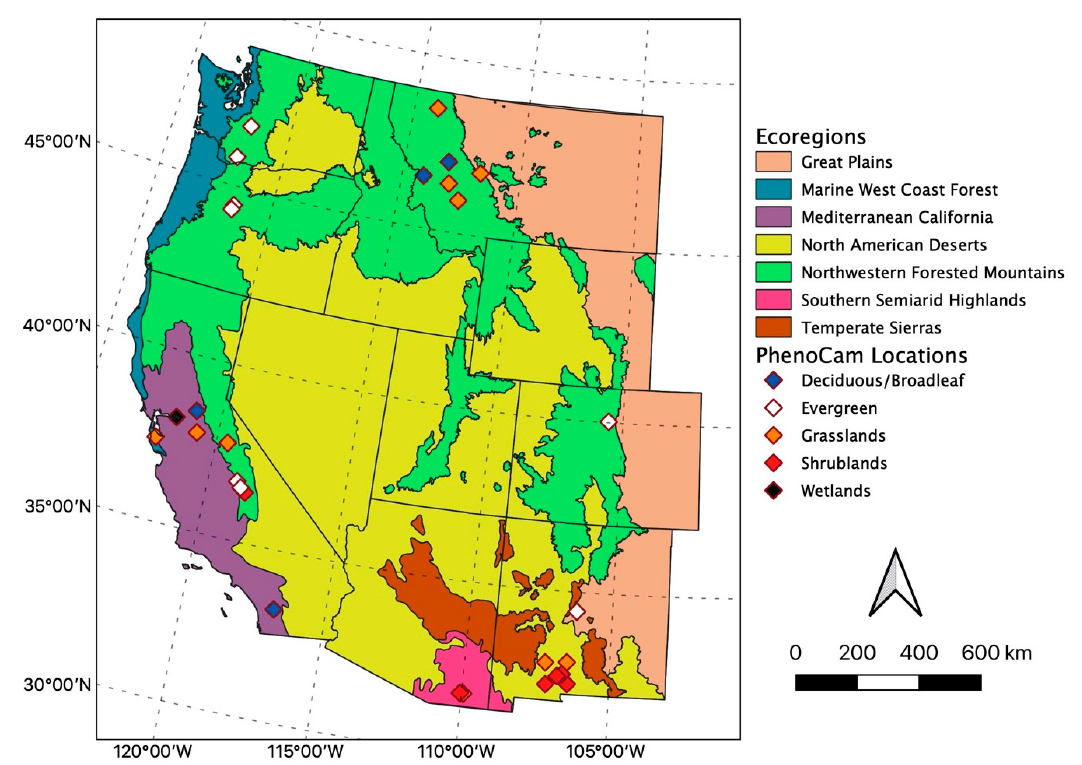
Figure 1. The western United States (11 states) overlaid with Level 1 Ecoregions [39] and the locations and vegetation types of 29 PhenoCam sites. Note that some PhenoCam locations are slightly jittered to prevent overlap and therefore may not represent exact location (but are always in same ecoregion).